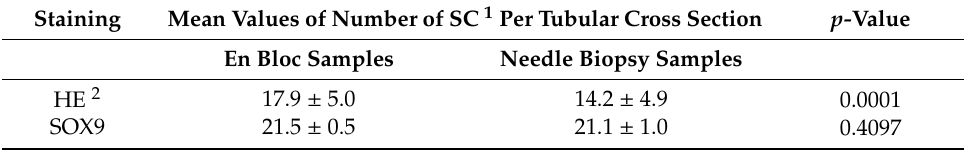
Table 6. Test results (i.e., p -value) of the mean value comparison of the SC count ± SD in en bloc and needle biopsy samples in SOX9-antibody or HE-staining. For SOX9 staining evaluating five young and two old bulls each per en bloc, all of the distal sample locations and the needle biopsy samples were